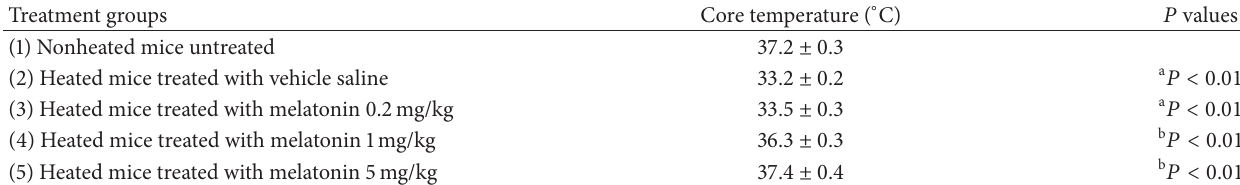
Table 1: Effects of heat exposure on body core temperatures of different groups of mice. Treatment